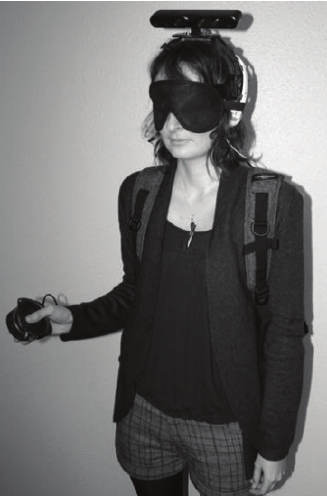
Figure 1: A blindfolded participant equipped with the set-up called MeloSee. The participant holds the distraction apparatus in her right hand.